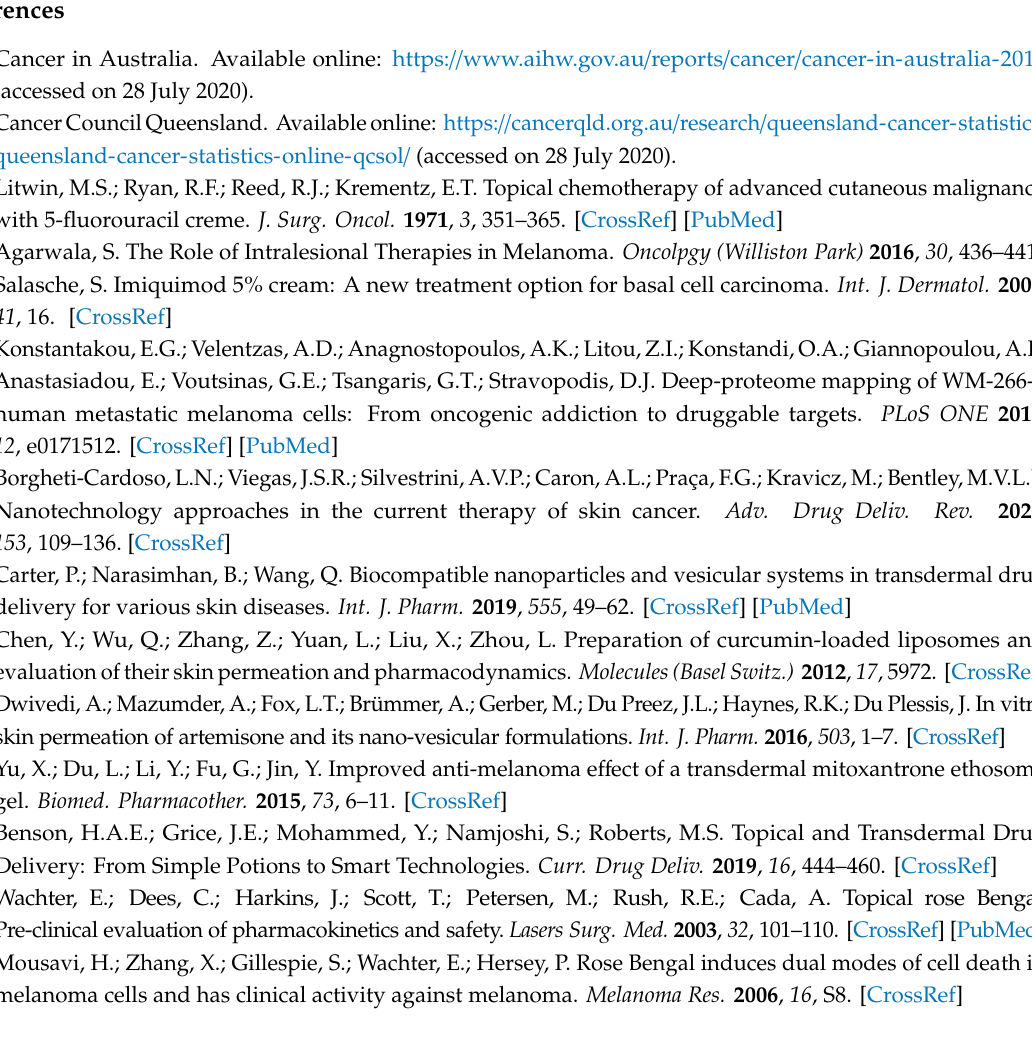
Figure S1: Pseudo ternary phase diagram of the SEME systems, Figure S2: Illustration of particle size distribution of blankandSEME,FigureS3: Shearsweeptest, FigureS4: Peakholdexperiment, FigureS5: Oscillatory(strain sweep) measurements, Figure S6: Skin penetration study by MPM-FLIM technique. Figure S7: Cell cycle histograms after RB treatment, Table S1: List of the SEME compositions, Table S2: Physicochemical properties of blank